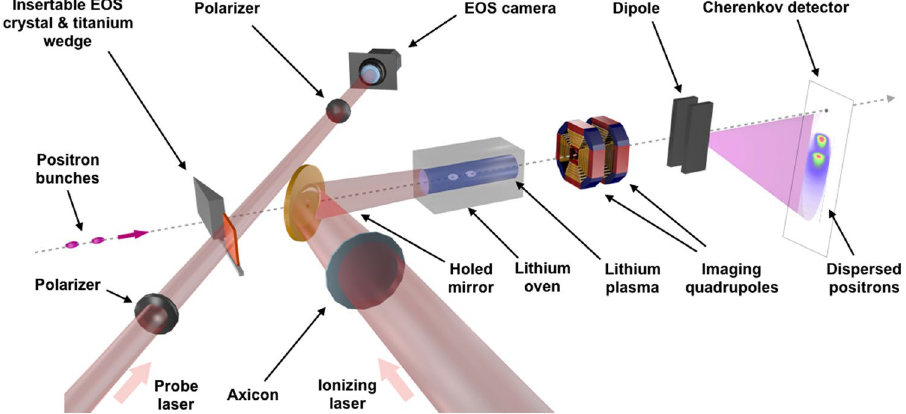
Figure 1. Experimental set-up. An intense laser is focused by an axicon in a lithium oven, and creates a uniform plasma by ionization of the first electron of lithium. Two positron bunches, a drive bunch at a central energy of 20.55 GeV, and a trailing bunch at a central energy of 20.05 GeV about 100 μ m behind, are sent into the plasma. An electro-optic sampler (EOS) and a titanium wedge can be inserted in the beamline. A Cherenkov imaging spectrometer is set up to measure the energy spectrum of the positrons after the interaction with the